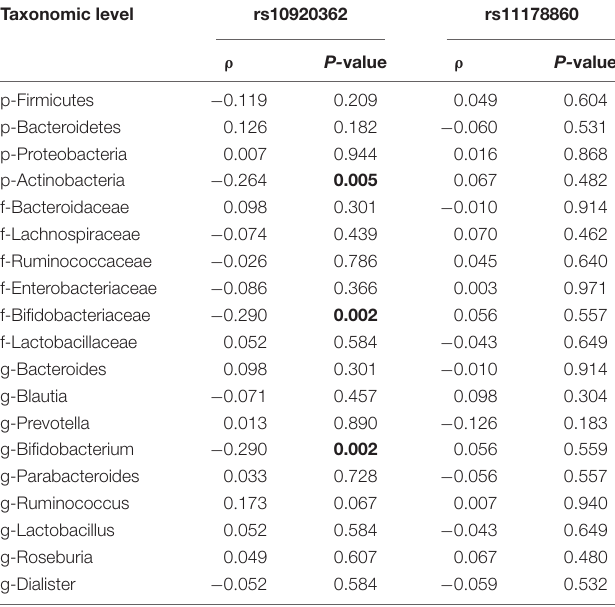
TABLE 5 | Spearman’s correlation analysis of the two common variants and gut microbiota abundance. Taxonomic level